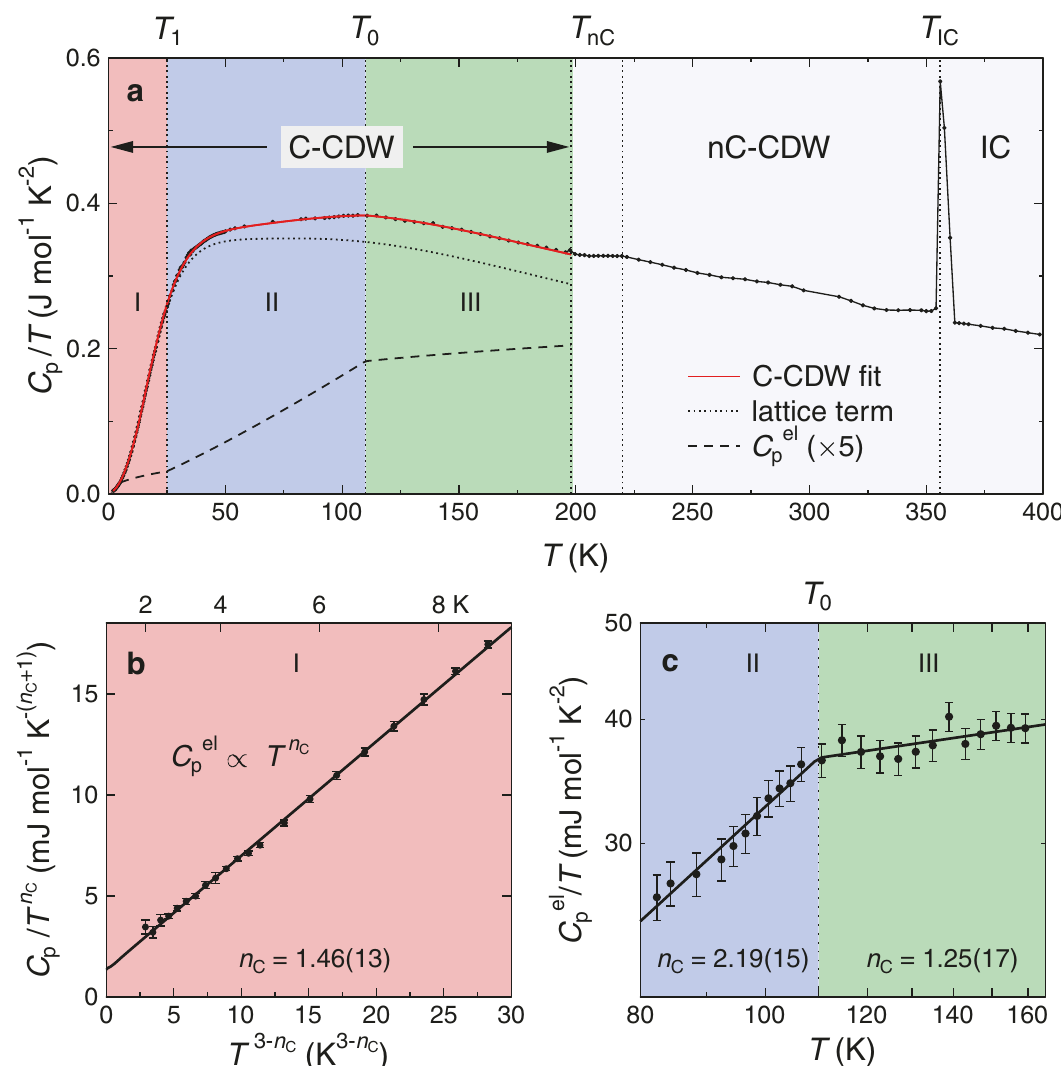
Fig. 4 Speci fi c heat. a Measured speci fi c heat over T plotted across a wide T range. The border between regions II and III is clearly signi fi ed by a maximum in C p / T . Within the C-CDW region, the data are fi tted by the sum of contributions from the crystal lattice and the electrons. b For the low-temperature region I the lattice contribution follows its asymptotic T 3 form and the power law exponent for the electronic contribution n C is straightforwardly obtained from a fi t to the data below 10 K. c In regions II and III the lattice contribution is large, but the T dependence of the electronic term can still be modeled using two effective values for n C . It is notable that region II has a signi fi cantly larger n C value than both regions I and III. Error bars indicate the estimated standard error of the AF ground state lies at a speci fi c value of control parameter g 1 (Fig. 6a). A possible association of g 1 could be made with ring- exchange, which is known to destabilize the magnetic phase of triangular-lattice Mott-Hubbard insulators 39 . The energies of the competing QSL states are assumed to depend on a second control parameter g 2 and at T = 0 continuous second-order QPTs would be expected between pairs of QSL-QD states (Fig. 6b). Moving to the fi nite T case, appropriate to our measurements, several additional factors come into play. Firstly, since the excitation spectrum is different between the adjacent QSL phases, as indicated by their difference in q , there will in general be a difference in entropy between the phases at the transition temperature, which would tend to turn the continuous second- order transition into a discontinuous fi rst-order transition. A second factor is that at fi nite T we expect the QPTs to evolve into second mechanism dominates over the fi rst. In this scenario, g 2 is